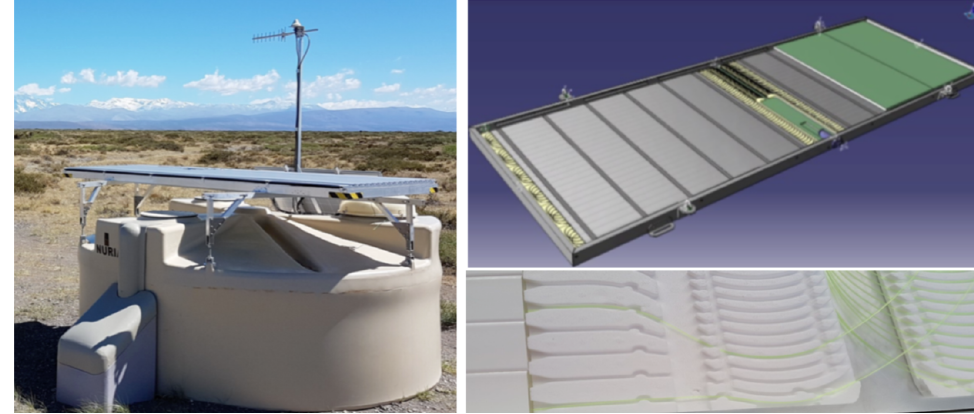
Figure 1. Left: One station of the AugerPrime Engineering Array, featuring the Surface Scintillator Detector (SSD) on top the WCD. Top-right: layout of the SSD. Bottom-right: details of the fibers in the